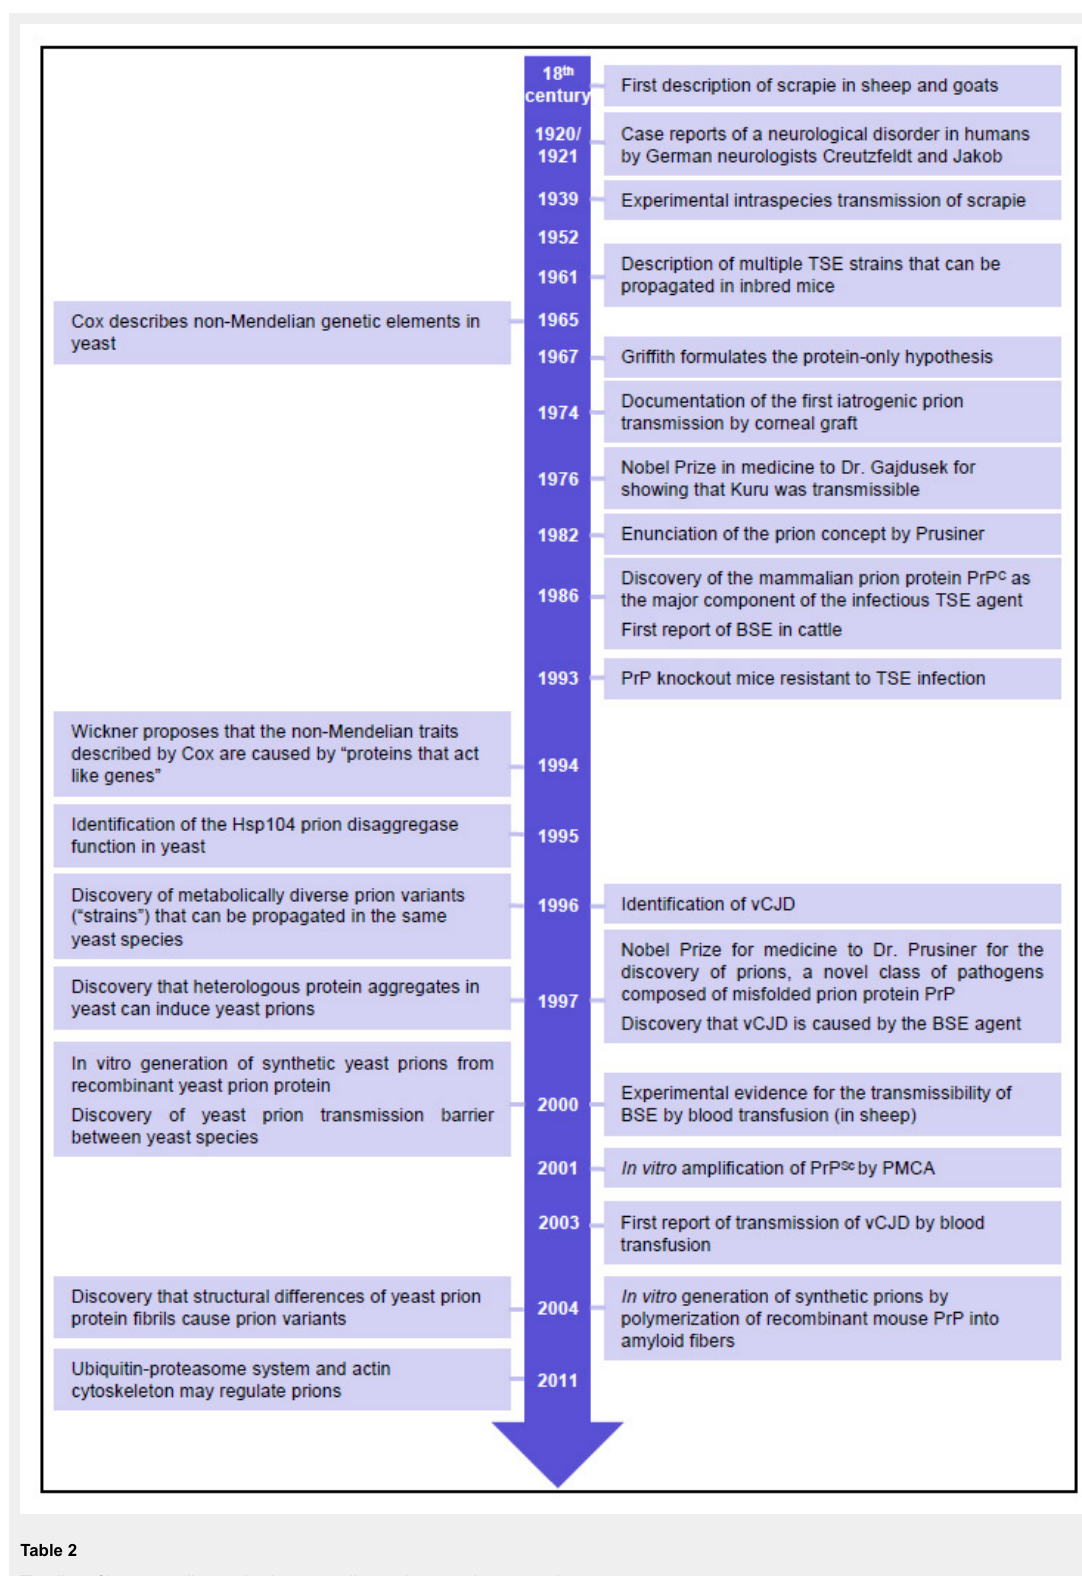
Timeline of important discoveries in mammalian and yeast prion